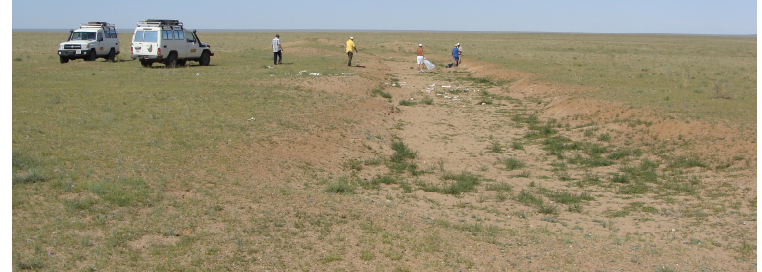
Figure 10. Excavation trench near historic point 2426/262, with animal bones.